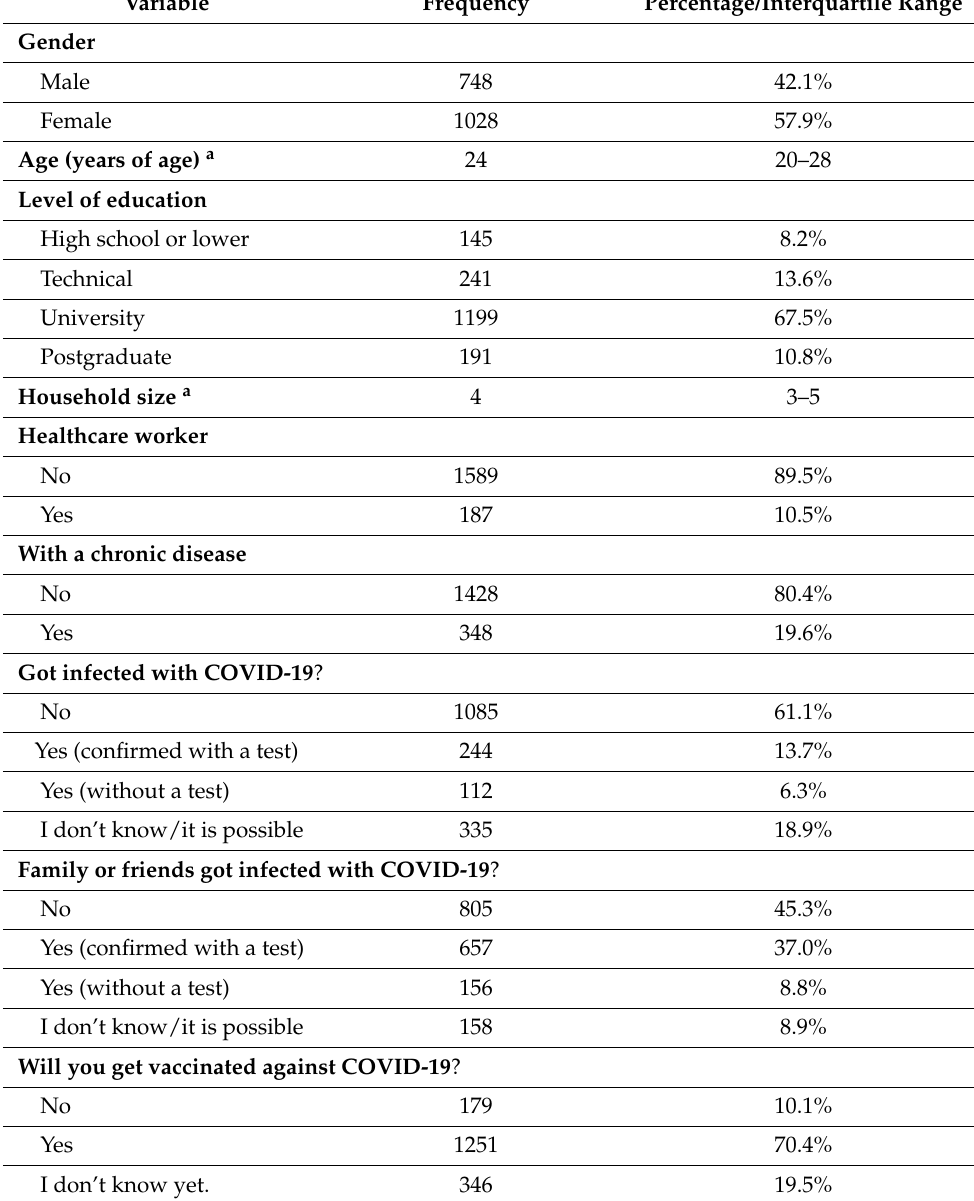
Table 1. Sociodemographic characteristics of